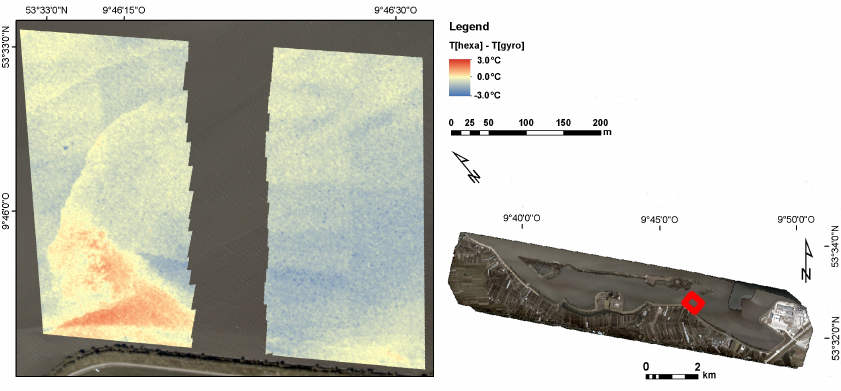
Figure 10. Difference between T TIR , hexa and T TIR , gyro calculated pixel by pixel after correction and calibration (overflight times: gyrocopter ˜17:05 and hexacopter 16:32–16:35 ( left ) and 17:01–17:04 ( right )). Gyrocopter RGB mosaic from 1 July 2015 16:45–17:45 in the